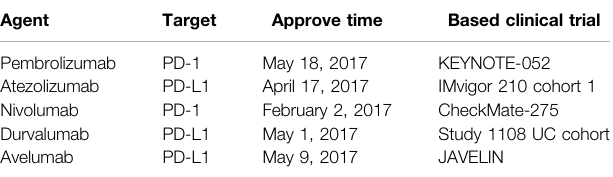
TABLE 1 | FDA approved ICIs in